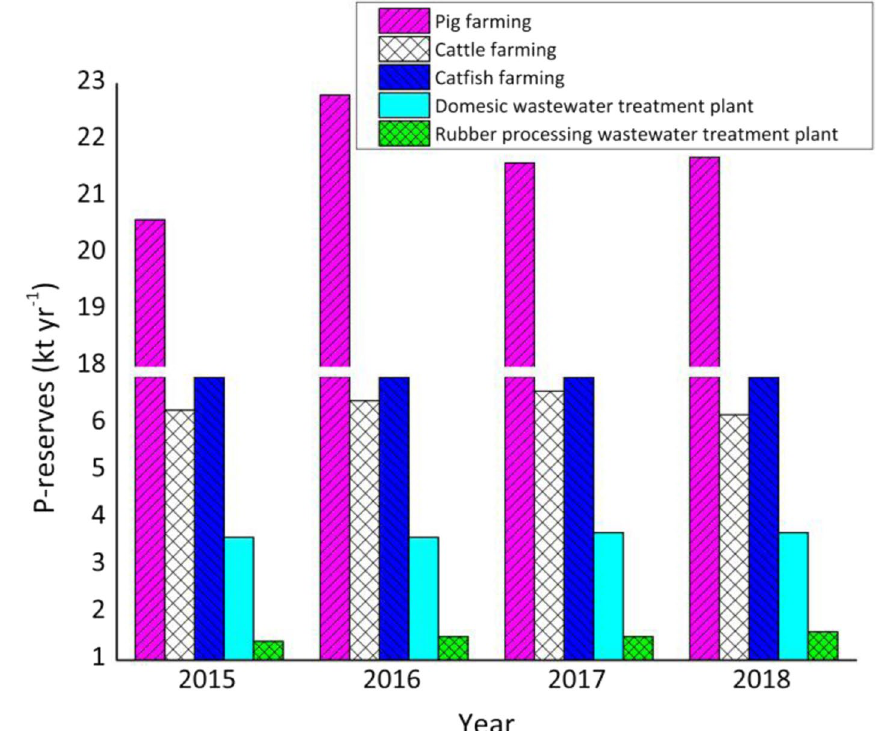
Fig. 1 Estimated P-reserves in studied waste